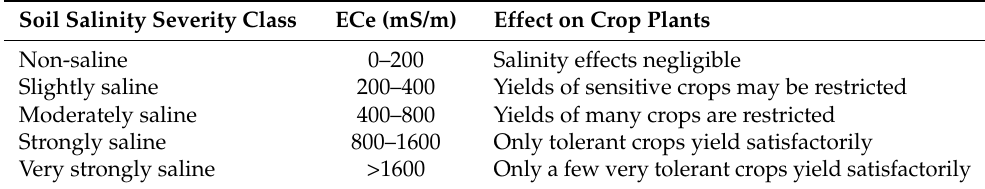
Table 3. Classification of soil salinity severity based on FAO standards